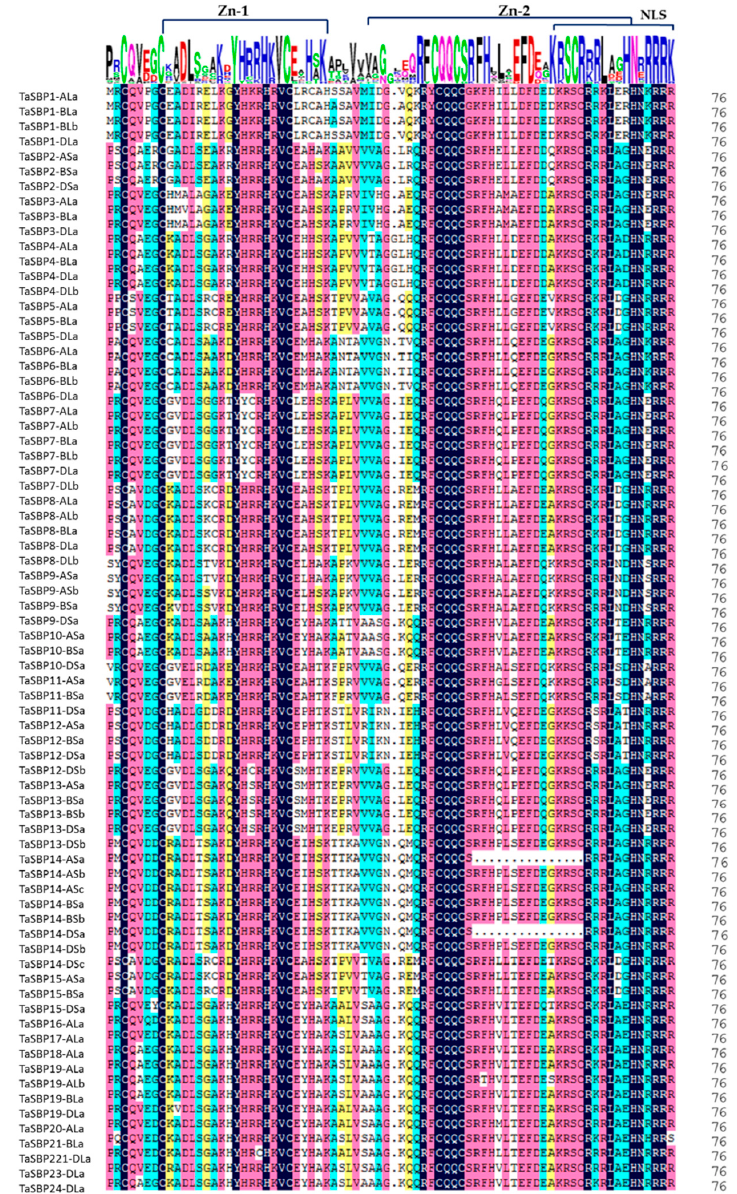
Figure 13. SBP-domain alignment of TaSBPs. Multiple alignment of the SBP domains of the 67 wheat sequences was obtained by DNAMAN6.0 software. Sequences LOGO view based on the result of sequence alignment was placed at the top of the figure. Zinc-binding sites and NLS structure are also labeled. Different colors represent the conservative degree of amino acids: black, 100% conserved; amaranth, 75–100% conserved; light blue, 50–75% conserved; yellow, 33–50% conserved; white, less than 33% conserved.